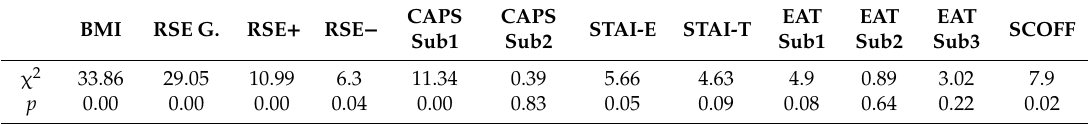
Table 4. Kruskal–Wallis test of the main variables of the study with group as